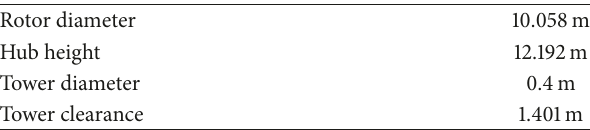
Table 1: NREL phase VI turbine